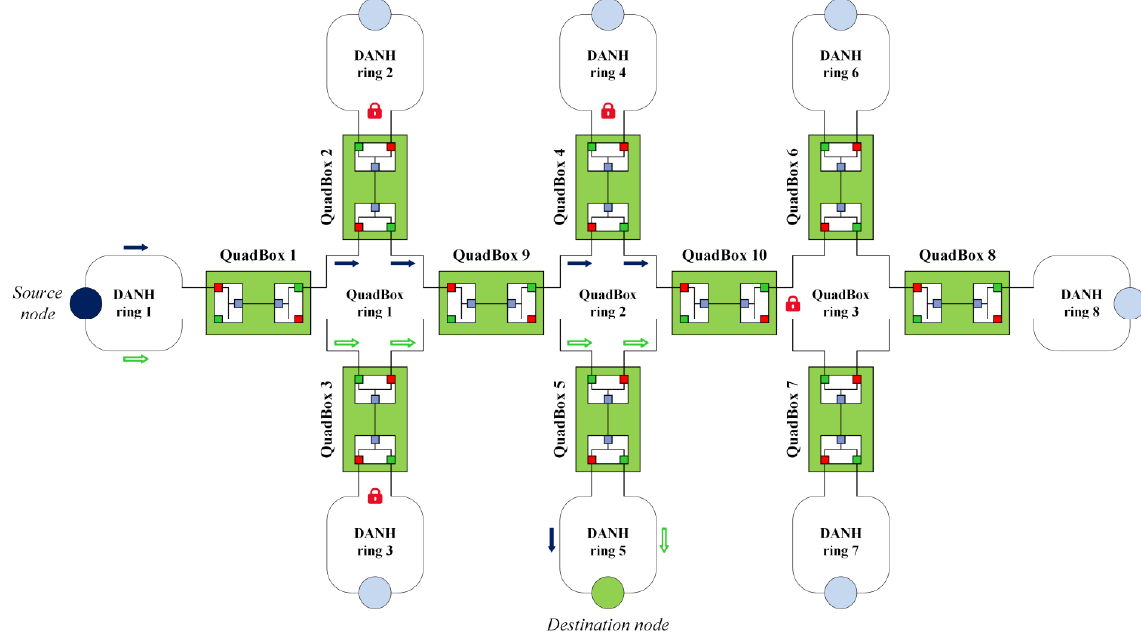
Figure 8. The process of filtering a unicast frame using the Filtering HSR Traffic (FHT)